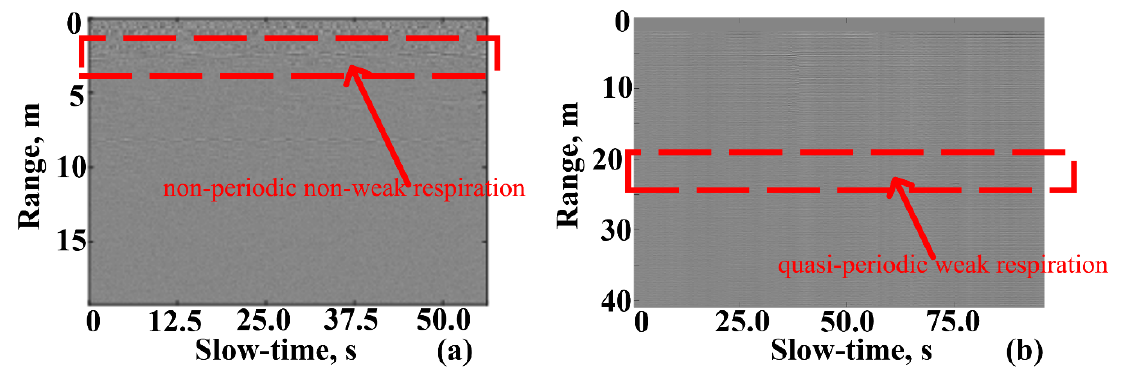
Figure 4. The slow-time range matrix including two types of vital signs. ( a ) Non-periodic non-weak respiration. ( b ) Quasi- periodic weak respiration.